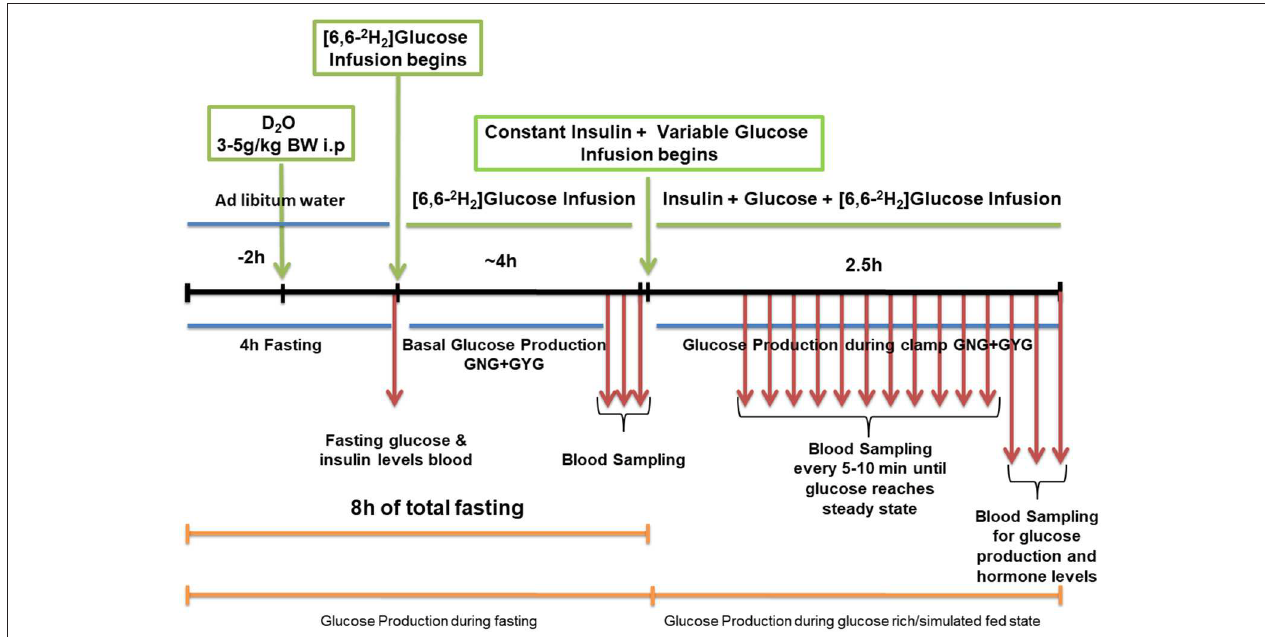
FIGURE 1 | Schematic work flow for measuring hepatic glucose production in low protein diet programmed lean type 2 diabetic (LP) rats during fasting and simulated fed condition (Image not to scale).